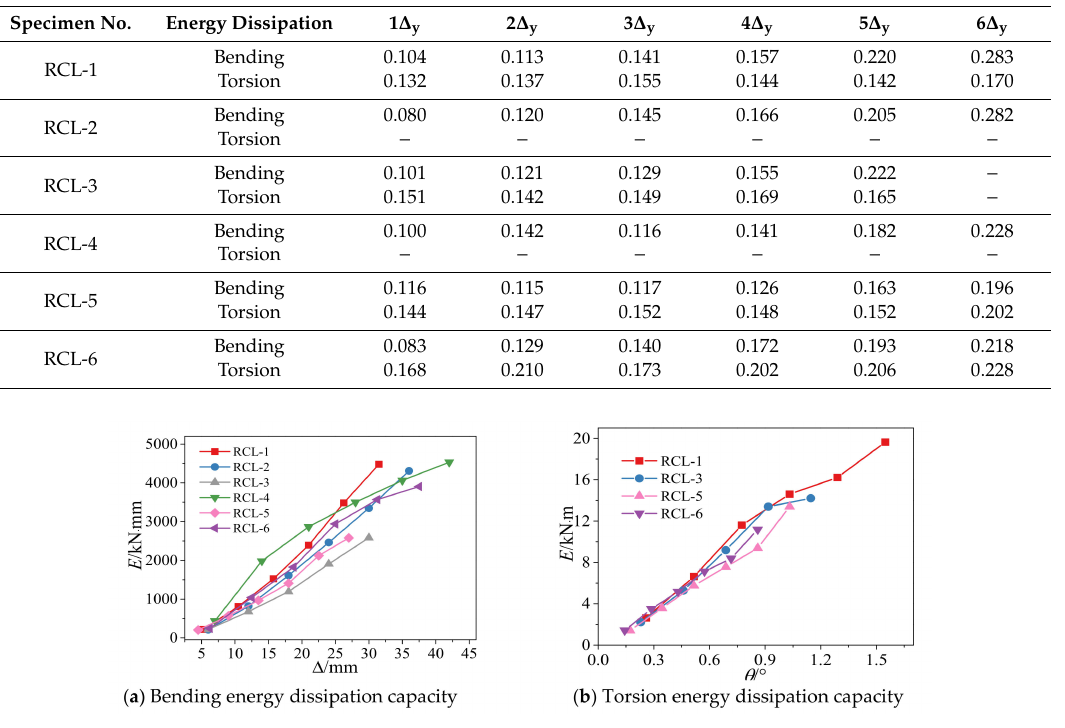
Figure 11. Bending and torsion energy dissipation capacity of